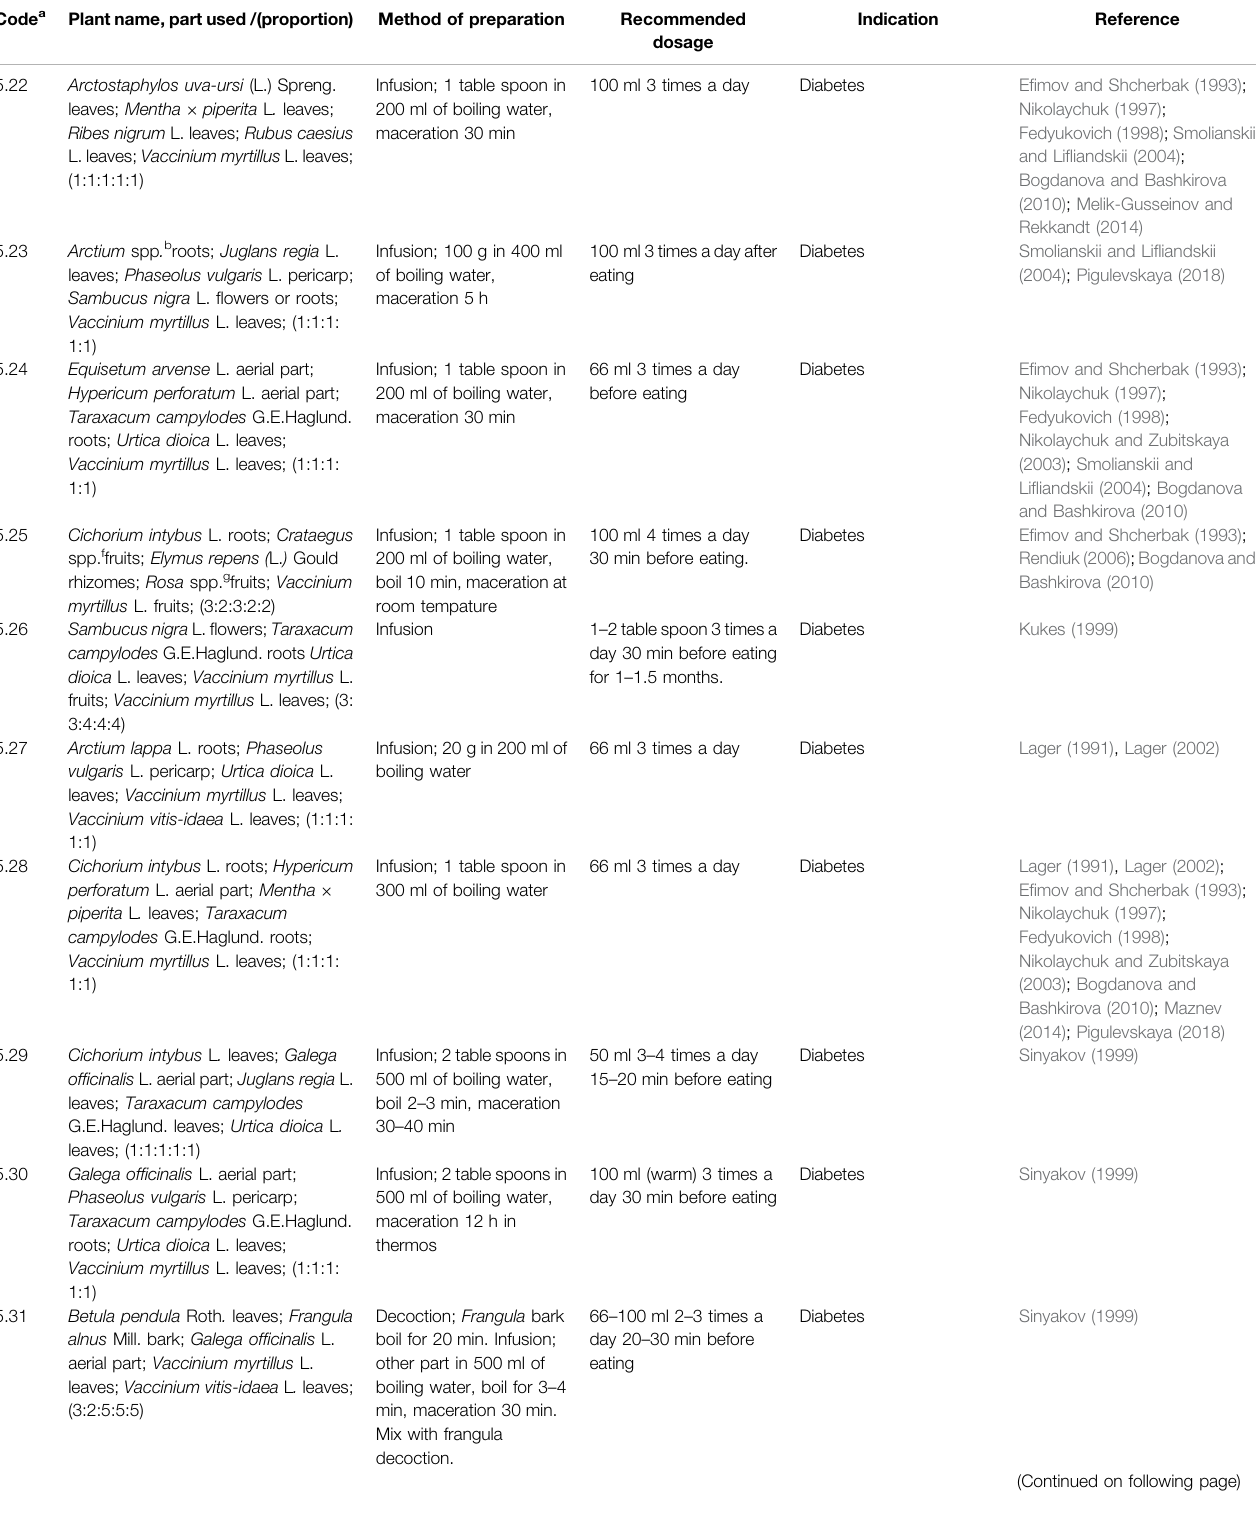
TABLE 1 | ( Continued ) The list of medical species used for the management of diabetes and related disorders in Russia. Code a Plant name, part used /(proportion) Method of preparation Recommended